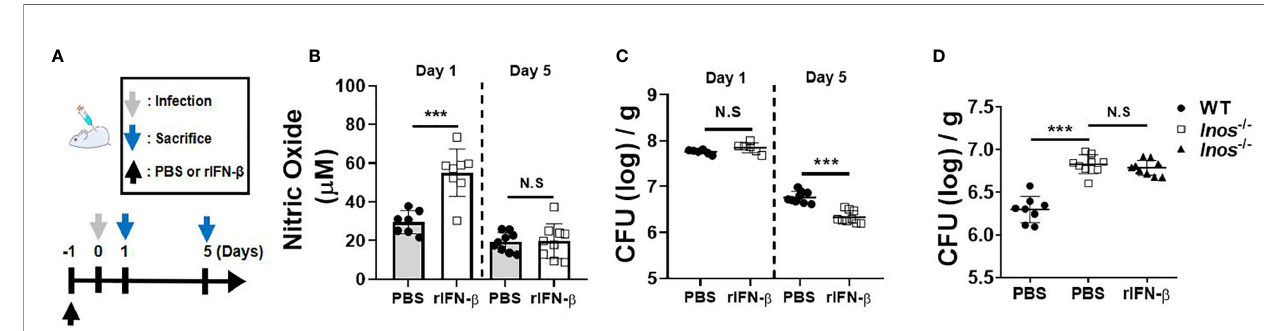
FIGURE 4 | Intranasal pretreatment of rIFN- b augments NO production and promotes the bacterial clearance in the lungs of mice infected with MAB. (A) The administration of rIFN- b and bacterial infection were performed according to the schedule indicated in the diagram. (B – D) WT or iNOS-de fi cient mice were administrated with PBS or rIFN- b (800 units per mouse) intranasally under anesthesia. After 1 day, mice were infected with 2 × 10 7 CFU of MAB per mouse intranasally; and the bacterial loads and nitric oxide levels in the lung lysate were determined at indicated days. (B – D) The results are merged data of two independent experiments (n = 4 – 6) (***p < 0.001). MAB, Mycobacterium abscessus ; WT, wild type; PBS, phosphate-buffered saline; CFU, colony-forming unit. NS, Not Statistically Signi